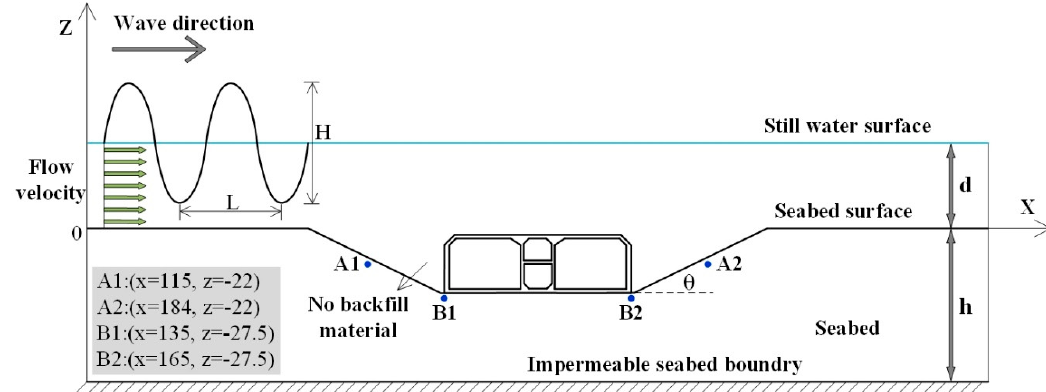
Figure 1. A sketch of the model for the wave-seabed-tunnel interaction.